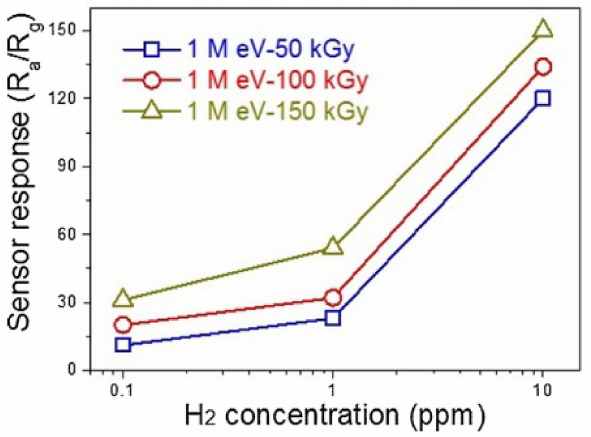
Figure 22. Response of ZnO NF sensors irradiated at different e-beam doses to 0.1, 1 and 10 ppm H 2 at T oper = 350 ◦ C. Reprinted with permission from [328]. Copyright 2019 Elsevier.